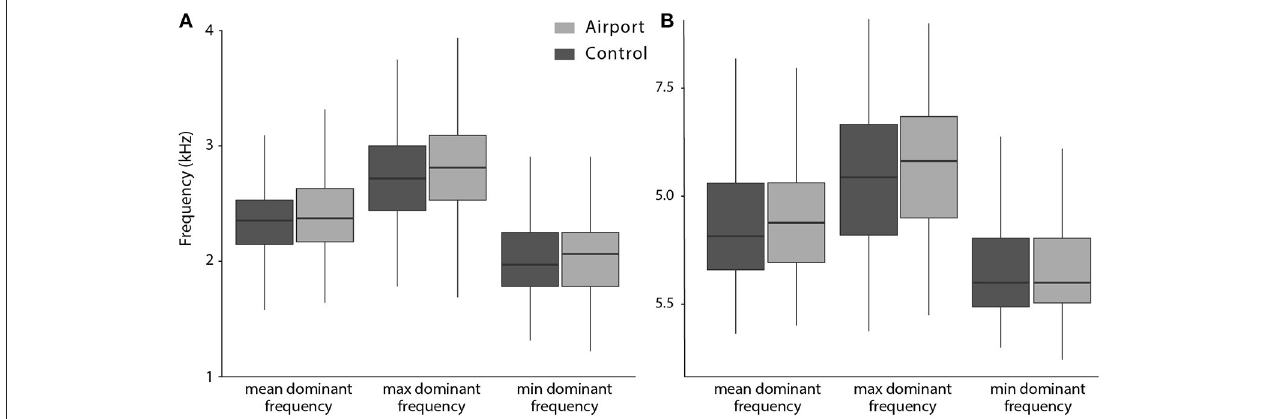
FIGURE 4 | Boxplots showing frequency characteristics of blackbird song in the two populations of the study. (A) Shows the mean, maximum and minimum dominant frequency of motif notes and (B) shows the mean, maximum and minimum dominant frequency of twitter notes.